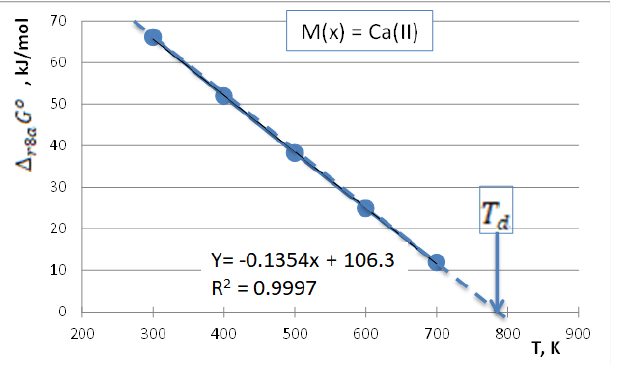
Figure 1. The temperature dependence of the standard molar Gibbs energy change of reaction (11) for M( x ) = Ca(II). The extrapolated line crosses zero at T d = 785 K.